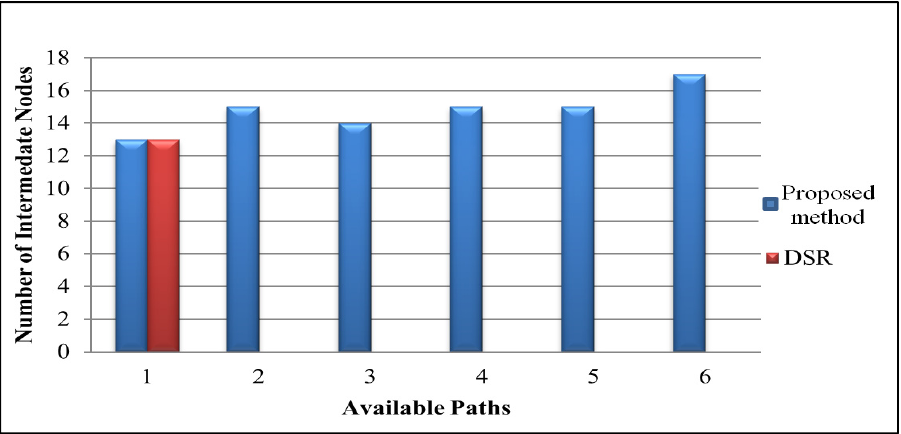
Figure 12. Intermediate node